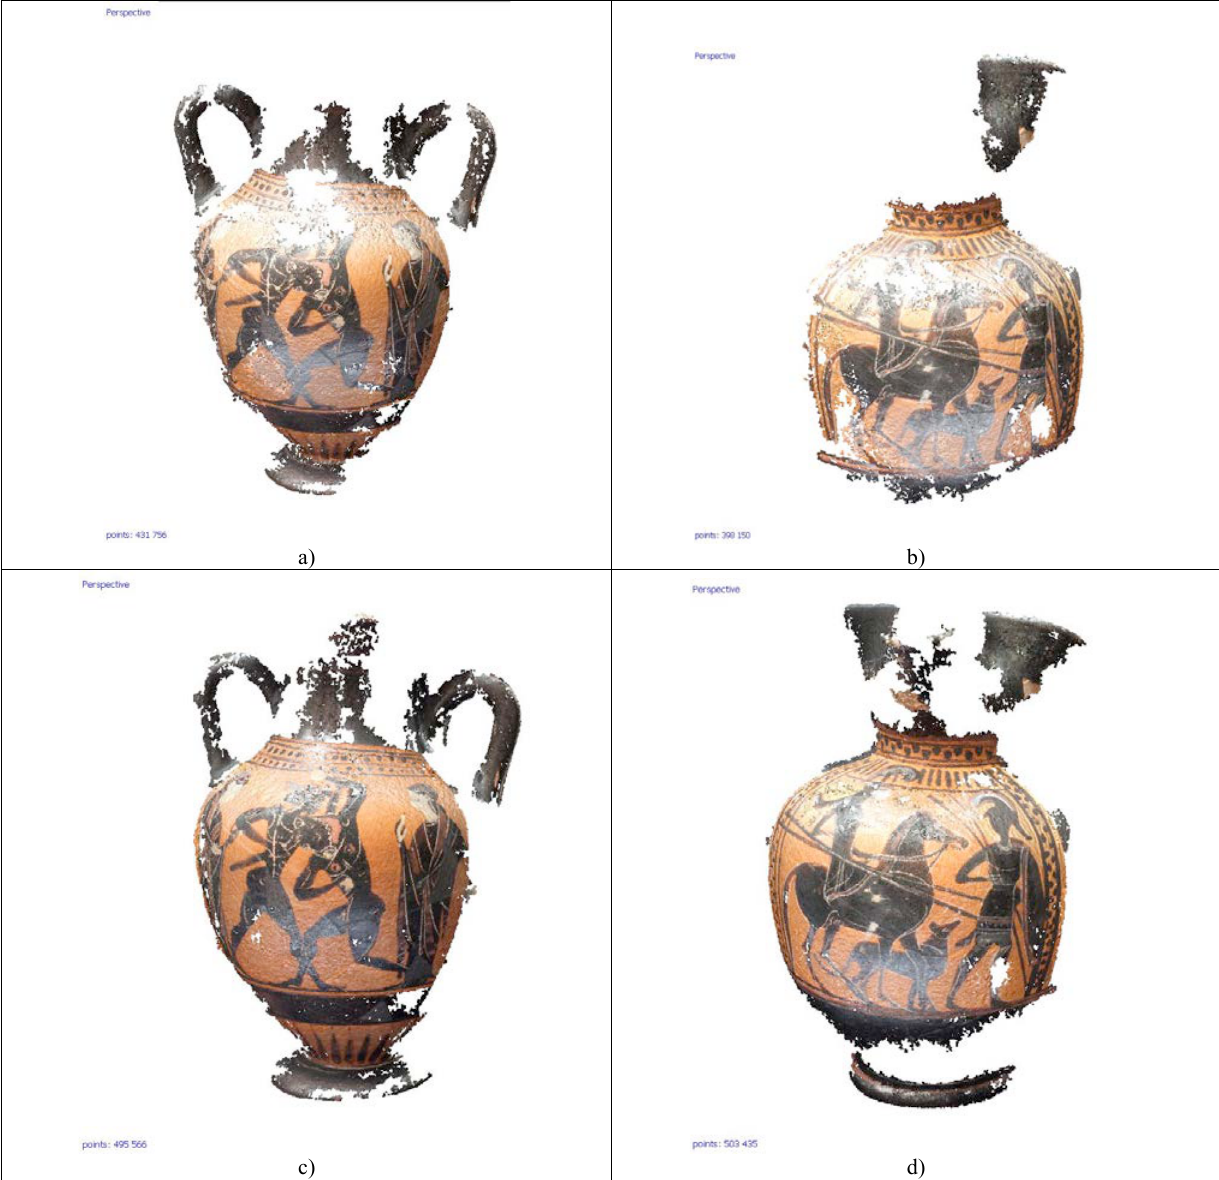
Figure 6. Image matching results on the ceramic test objects with and without polarizing filter: a, c) Greek vase; b, d) Etruscan vase. The first row (a, b) acquired without any polarizing filter while the second (c, d) with polarizing filter.